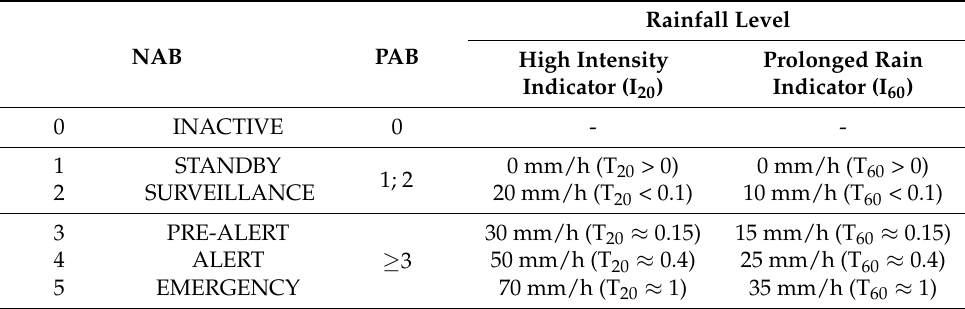
Table 1. BCASA criteria to activate the alert level in Barcelona (NAB). Levels are based on